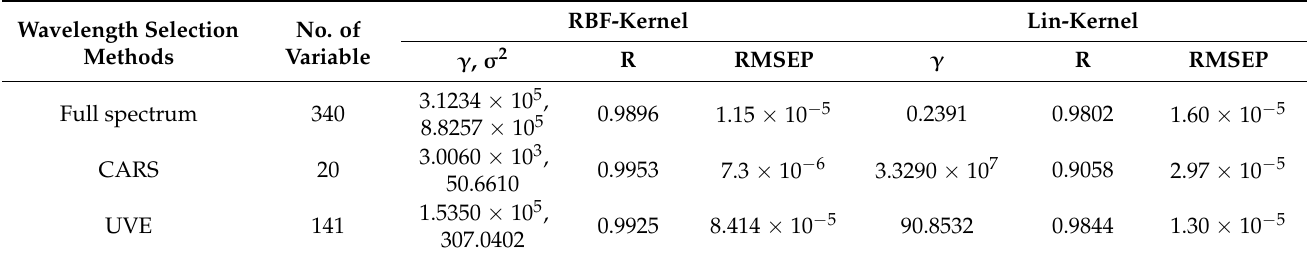
Table 3. LS-SVM models performance by using various methods for selecting wavelength variables.